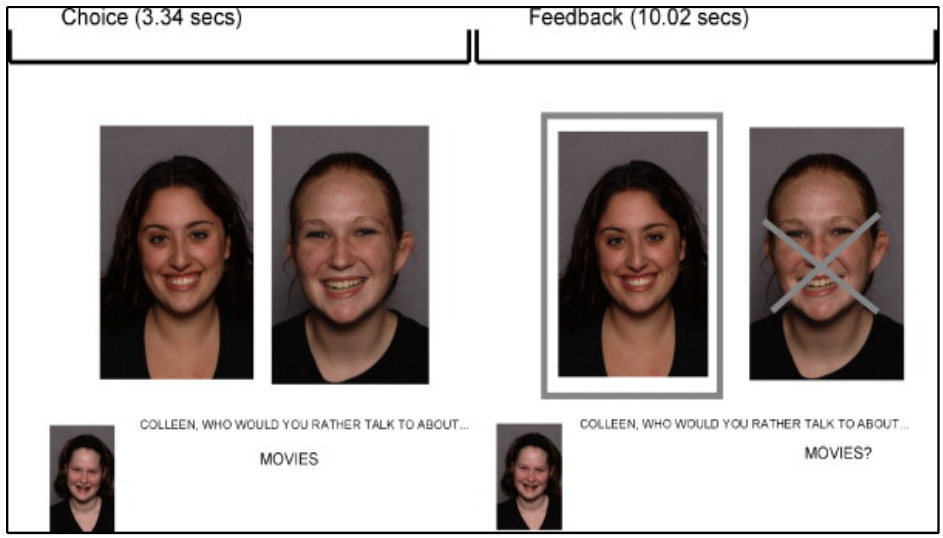
Figure 1. Depiction of the Chatroom Interact Task rejection trial feedback. Choice and feedback time described in seconds.